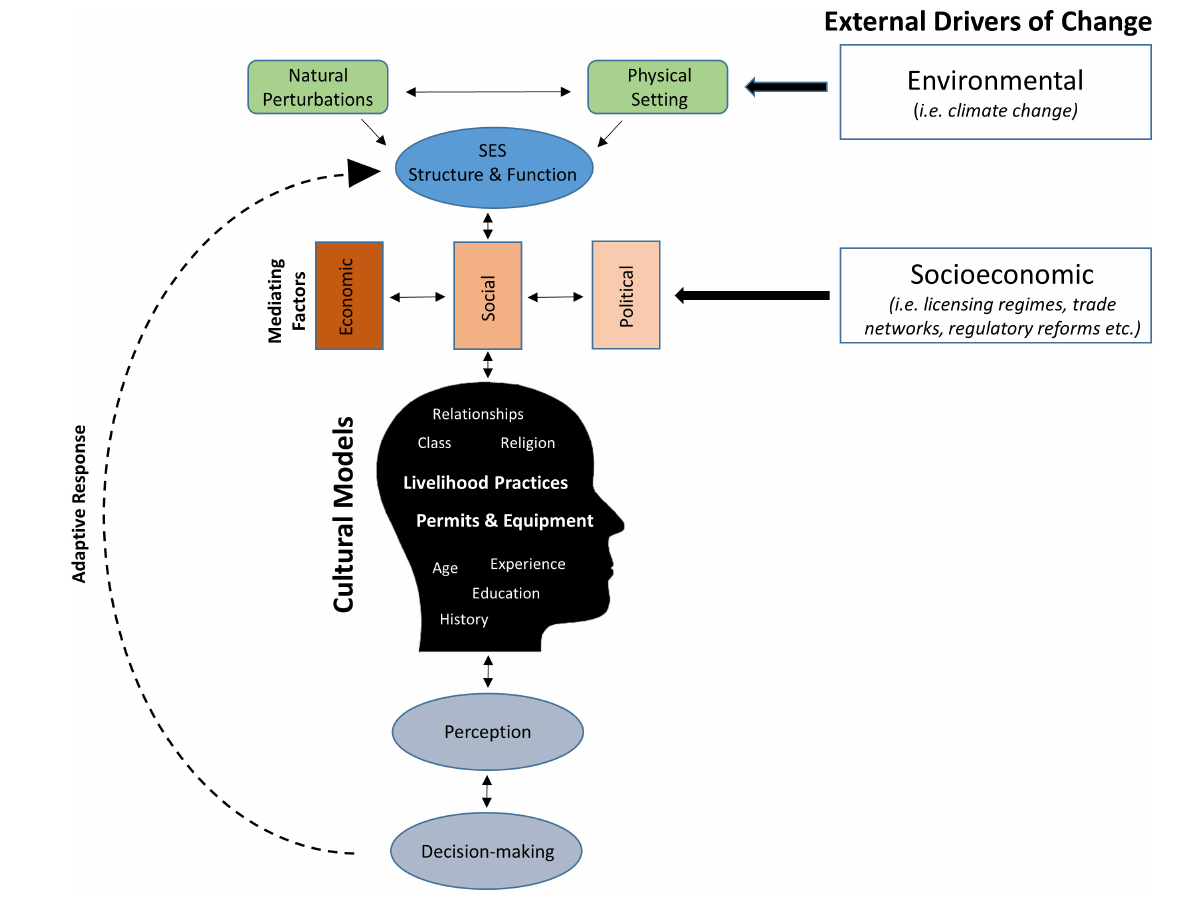
FIGURE 5 | Resource users’ knowledge of and interactions within marine social-ecological systems are influenced by the cultural models which mediate their perception of and response to environmental and socioeconomic change. Bolded items (i.e., livelihood practices, permits, and equipment) represent critical factors driving divergent cultural models within SSF